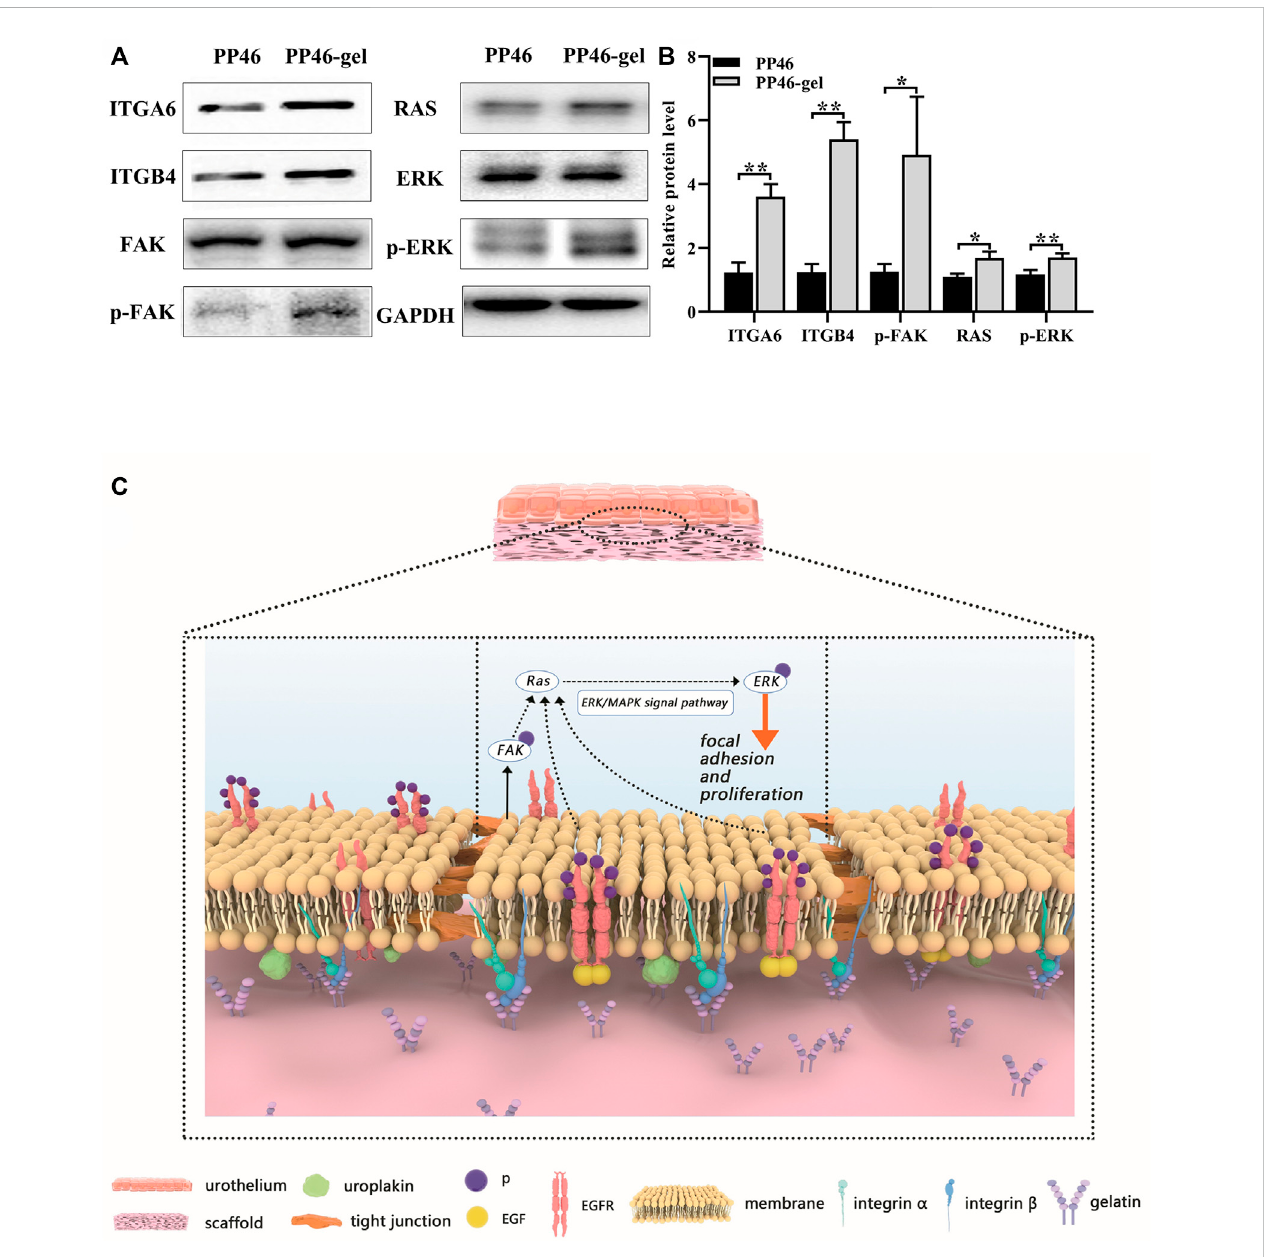
FIGURE 7 Studies of biological mechanisms. (A) Protein levels of ITGA6, ITGB4, FAK, p-FAK (Tyr 397), Ras, ERK, and p-ERK detected by Western blotting with GAPDH as the control. (B) Statistical analysis of ITGA6, ITGB4, p-FAK, Ras, and p-ERK. Cells were cultured for 7 days. (C) Schematic diagram regarding the molecular mechanism of the PP46-gel scaffold acting on the urothelial cells. Data are presented as mean ± SD (* p < 0.05; ** p <